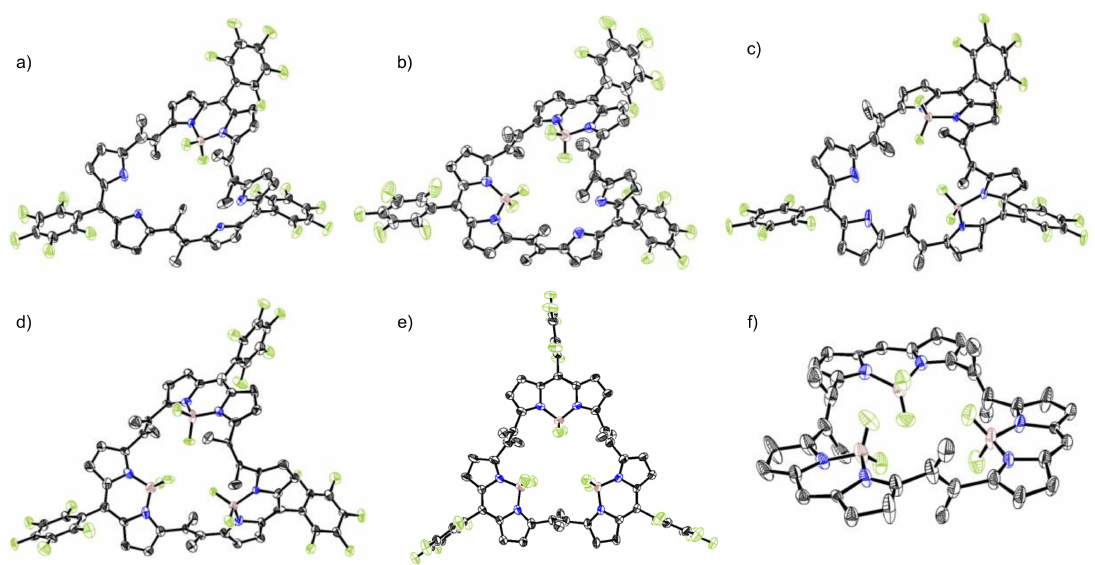
Figure 5. Crystal structures of ( a ) BF 2 -Me-Hex, ( b ) 2BF 2 -Me-Hex(a), ( c ) 2BF 2 -Me-Hex(b), ( d ) 3BF 2 -Me-Hex(a), and ( e ) 3BF 2 -Me-Hex(b), ( f ) side view of 3BF 2 -Me-Hex(b). The hydrogen atoms of five compounds, and pentafluorophenyl groups of ( f ) were omitted for clarity. The thermal ellipsoids are shown at 50% probability.